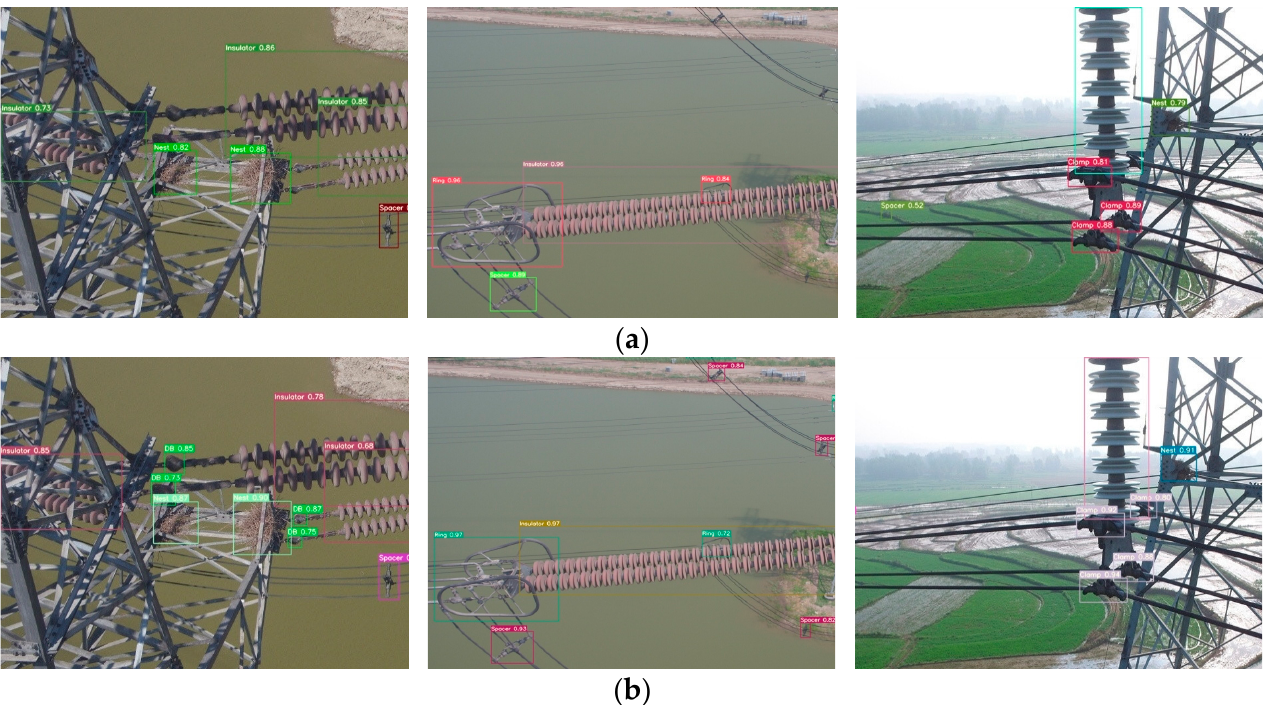
Figure 3. Comparative experiment. ( a ) Original network; ( b ) optimized network.